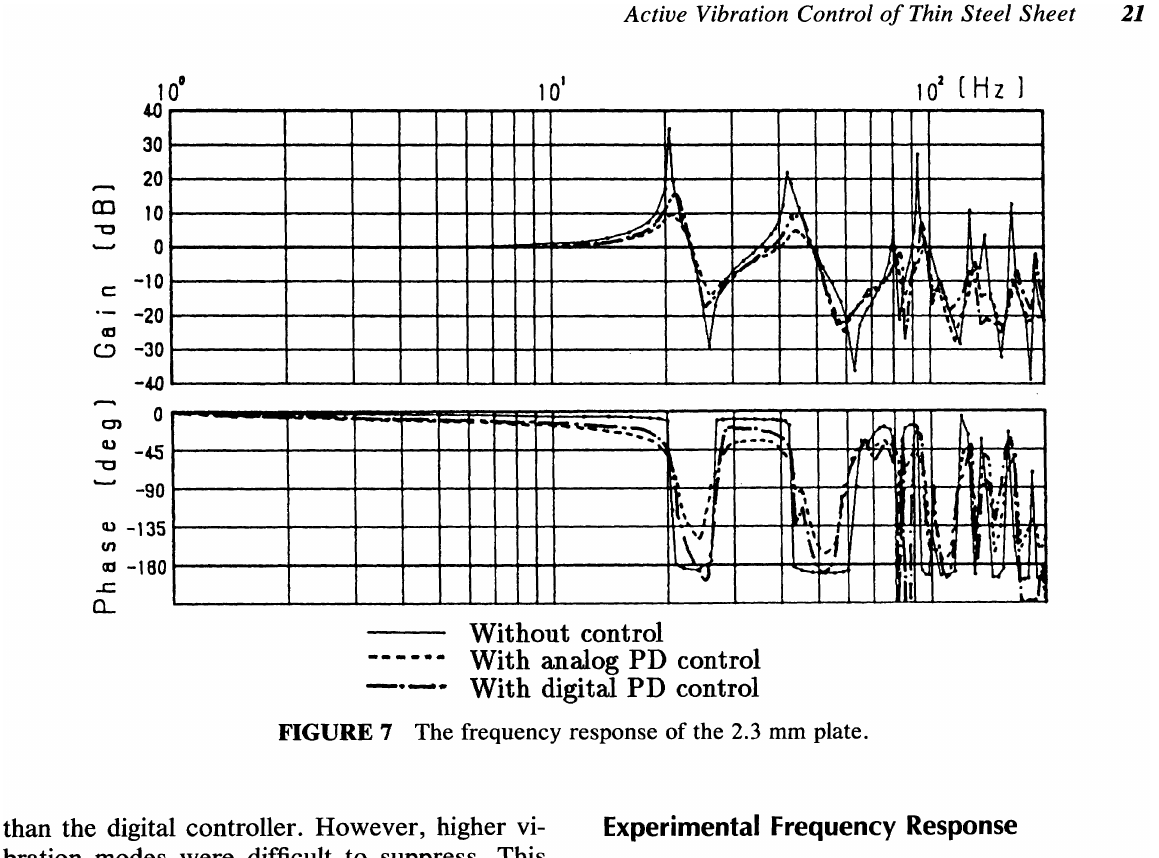
FIGURE 7 The frequency response of the 2.3 mm plate.